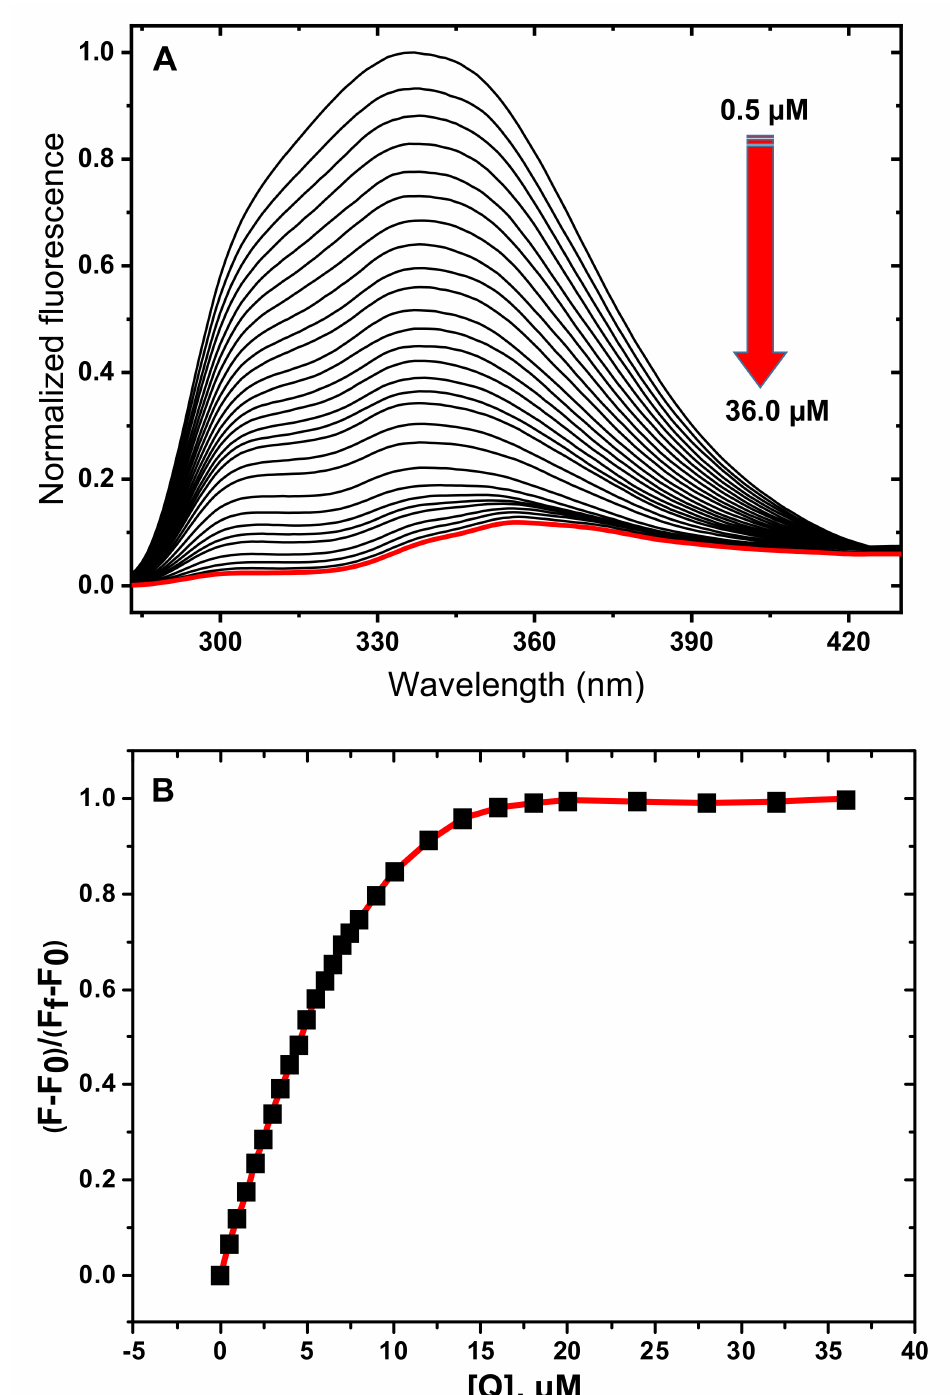
Figure 2. ( A ) Fluorescence spectra of 20.0 µ M HSA in the presence of PAZ with concentrations varying from 0.5 µ M to 36.0 µ M at pH 7.4 and 298.15 K. ( B ) Corresponding binding isotherm and fitting curve (F 0 : initial fluorescence intensity, F f : final fluorescence